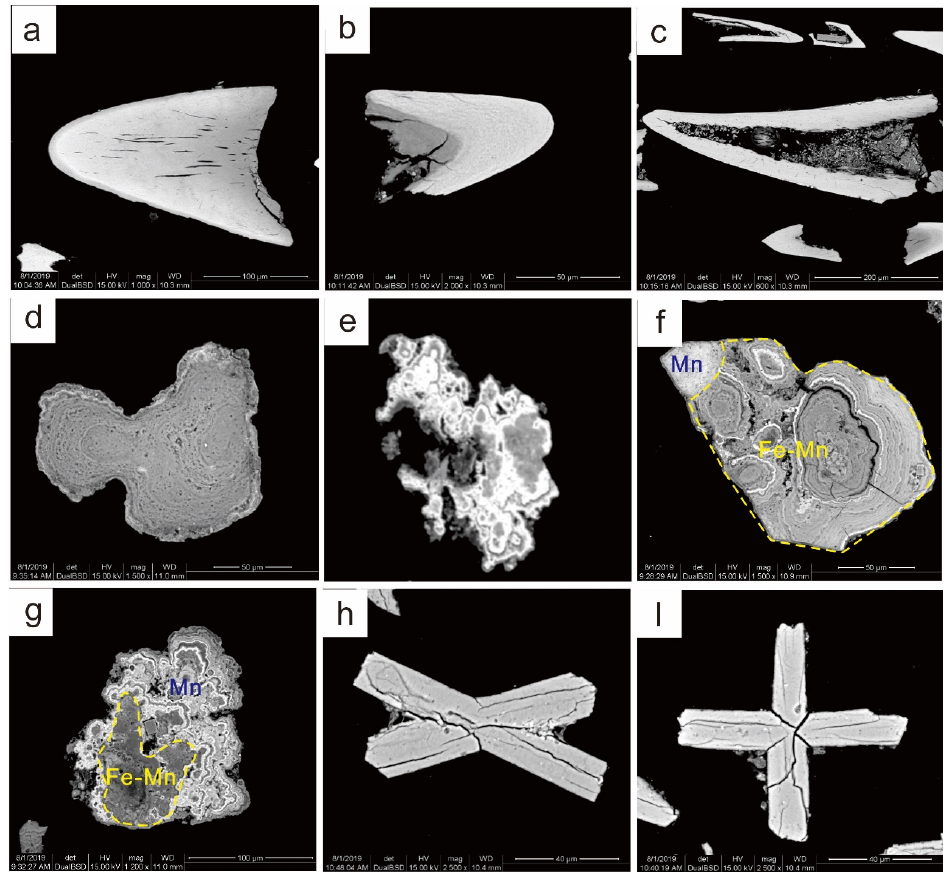
Figure 4. SEM images of the main constituents in the samples. ( a – c ) Bioapatite (fish teeth). ( d ) Fe–Mn micronodules. ( e ) Mn micronodules. ( f ) and ( g ) Mn micronodules in the outer rim of Fe–Mn micronodules. ( h ) and ( i ) Phillipsite.